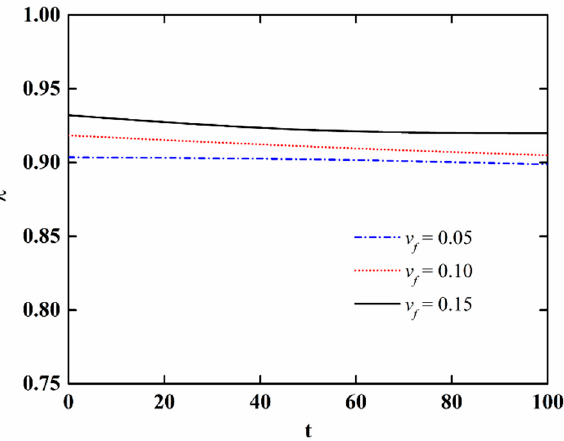
Figure 11. Variation in the imperfection sensitivity of imperfect NFRC cylindrical shells with aging time.